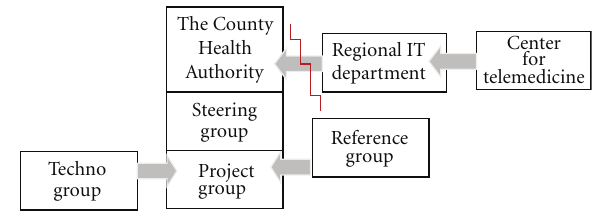
Figure 1: Project